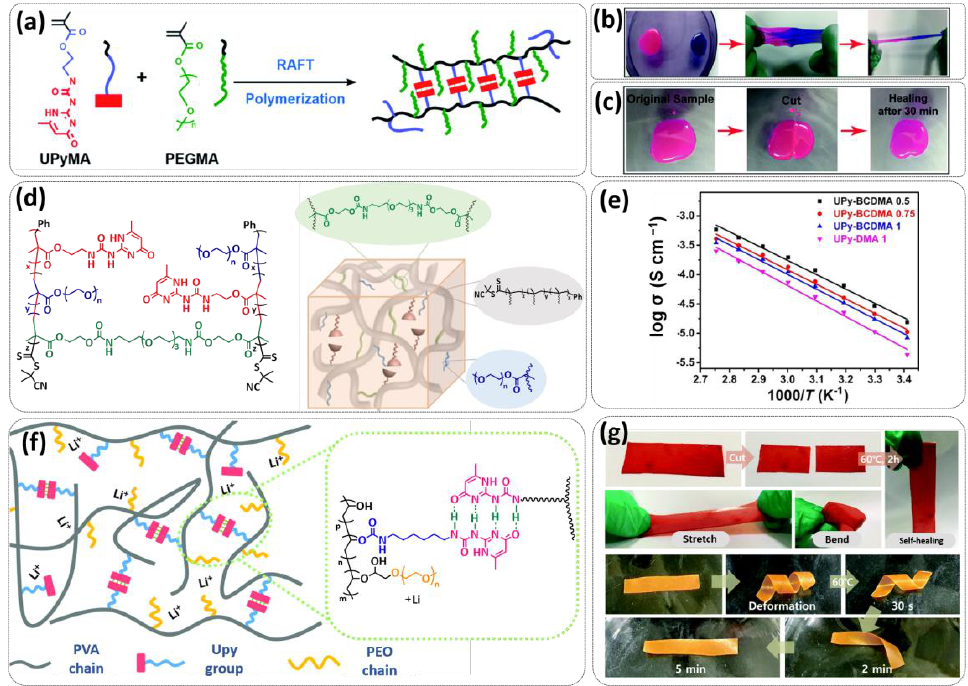
Figure 3. ( a ) Schematic illustration of the synthesis of brush-like copolymer starting from UPyMA and PEGMA monomers. ( b ) Optical images showing the self-healing behavior of PEG5-UPy at ambient conditions (above) and ( c ) at 60°C (below). Reproduced from [79] with permission from the Royal Society of Chemistry. ( d ) Schematic illustration of the dual-network of self-healing UPy-BCDMA. ( e ) The temperature dependence of the ionic conductivity for UPy-BCDMA copolymer electrolytes. Reproduced with permission from [71]. Copyright © 2018 Wiley-VCH Verlag GmbH & Co. KGaA, Weinheim. ( f ) Schematic illustration of the preparation process of PVA-UPy-PEG. ( g ) Optical images of the self-healing (up) and shape-memory (down) behavior of PVA-UPy-PEG. Reproduced from [76] with permission from the Royal Society of Chemistry.